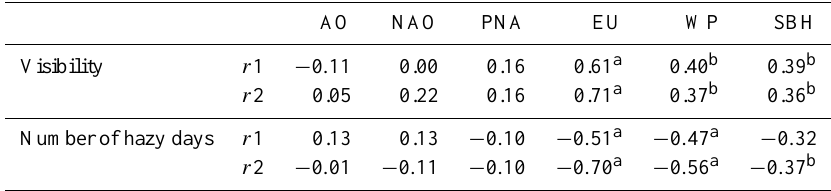
Table 1. Correlation coefficients of visibility and hazy days and circulation indices. AO NAO PNA EU WP SBH Visibility r 1 − 0 . 11